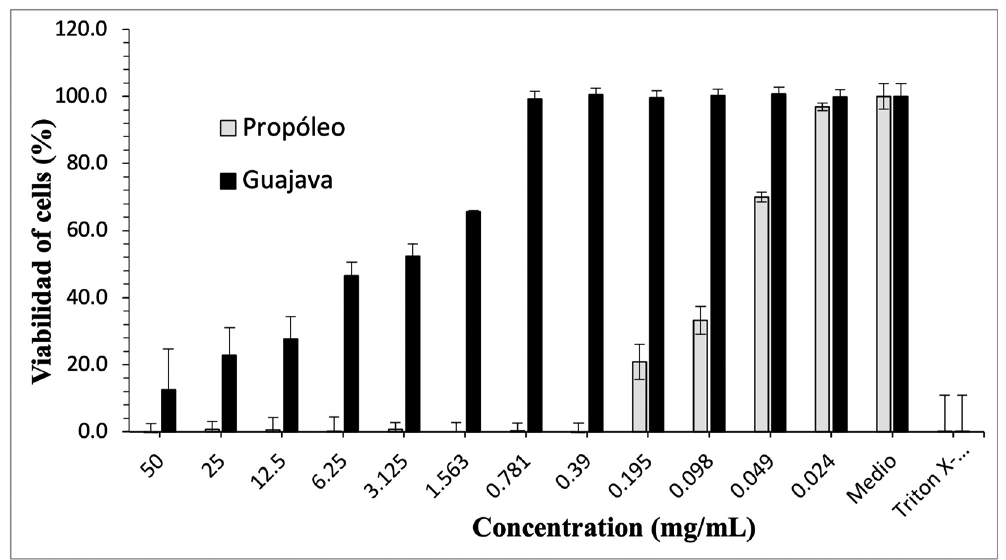
Figure 4. Viability of human gingivalfibroblasts byeffect of ethanolicextracts concentrations of propolis and P. guajava. The growth of human gingival fibroblasts remains in control with propolis doses of 50-0.39 mg/mL, with rapid growth at lower doses; in contrast, with gujava, while at doses of 50 mg/mL cell growth was pc more than 10%, it begins to increase considerably up to doses of 0.781 mg/mL, at which it reaches maximum growths.